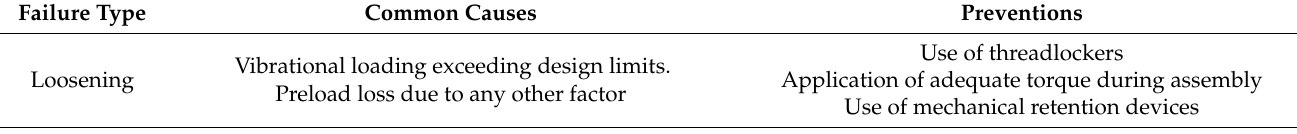
Table A1. Types of failures of threaded fasteners and their